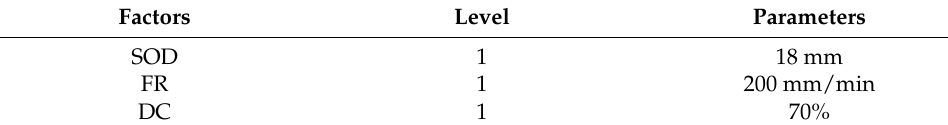
Table 6. Optimized process parameters.